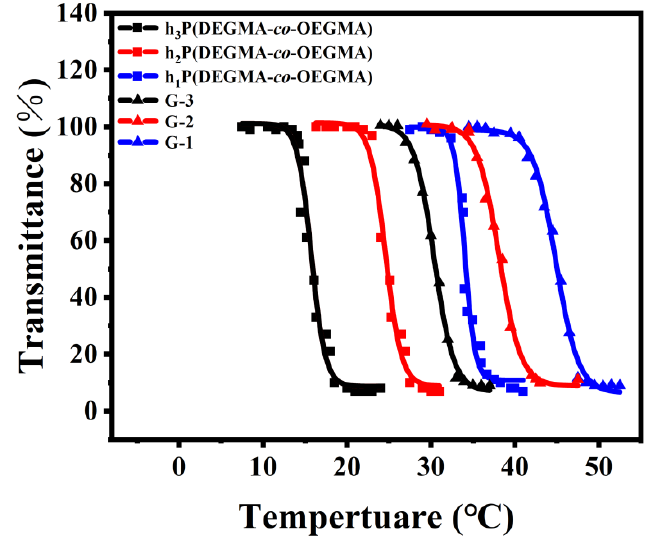
Figure 4. Plots of transmittance versus temperature for aqueous solutions of h 3 P(DEGMA- co - OEGMA) (black line with square), G-3 (black line with triangle), h 2 P(DEGMA- co -OEGMA) (red line with square), G-2 (red line with triangle), h 1 P(DEGMA- co -OEGMA) (blue line with square), and G-1 (blue line with triangle). The concentration of the sample solution is 1 mg/mL.